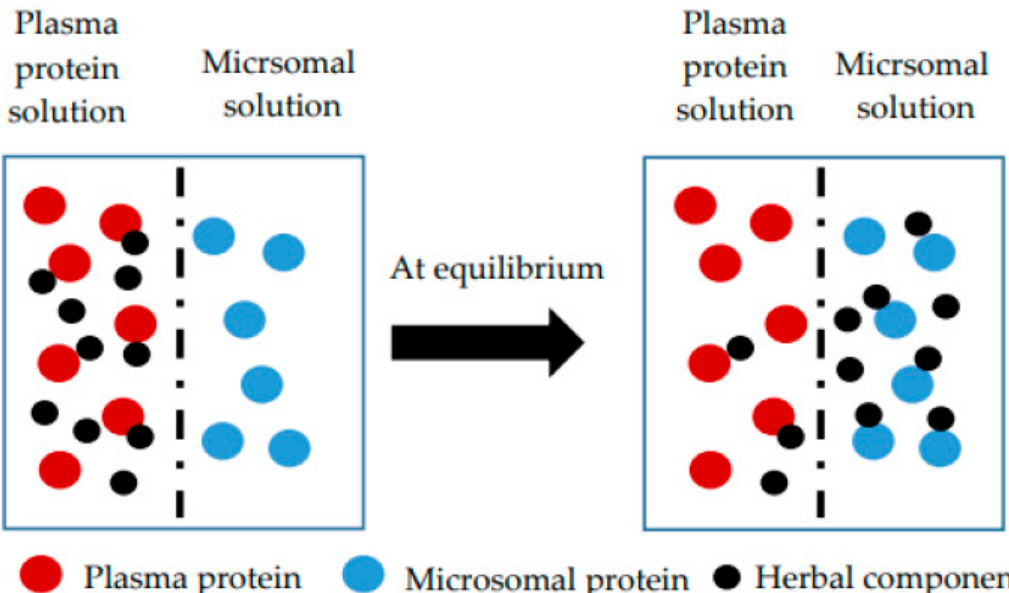
Figure 5. Schematic representation of a competitive dialysis approach making use of plasma-microsomal protein co- incubation according to